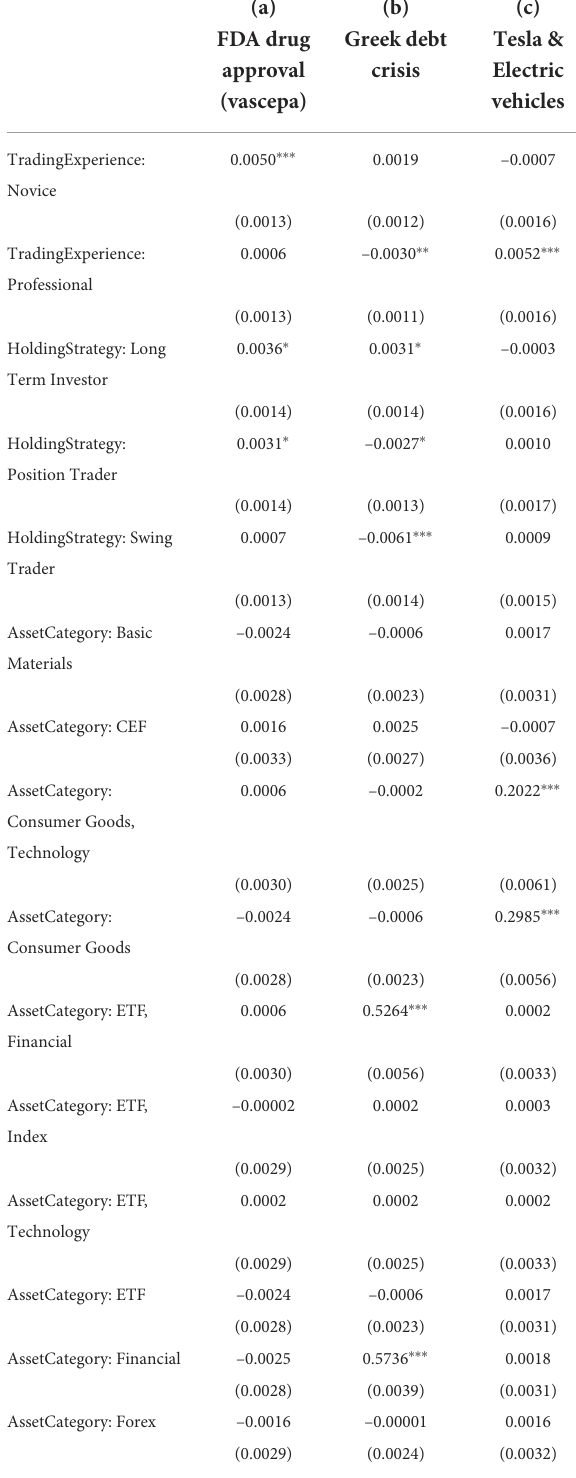
TABLE 2 The generalized linear model regression estimation results with statistical significance of three exemplary topics (FDA